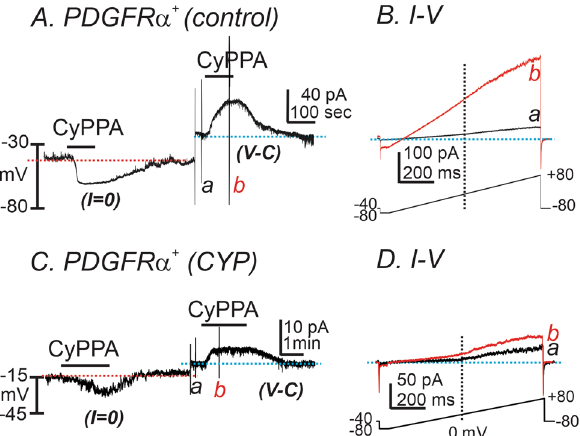
Figure 4. The effect of SK channel activator on membrane currents and potential in PDGFRα + cells from control and CYP-treated mice. ( A ) In detrusor PDGFRα + cells from control bladders, CyPPA (10 μM) induced membrane hyperpolarization under current clamp ( I = 0, red dot line). In the same cell, CyPPA activated outward current (current above blue dotted line) at a holding potential of − 40 mV under voltage-clamp mode (V-C). ( B ) Current responses to ramp-depolarizations from ( A ) before (a) and during (b) CyPPA. Inset denotes voltage-protocol. ( C ) In detrusor PDGFRα + cells from CYP-treated bladders, CyPPA (10 μM) induced membrane hyperpolarization under current clamp ( I = 0, red dot line). In the same cell, CyPPA activated outward current (current above blue dotted line) at a holding potential of − 40 mV under voltage-clamp mode (V-C). ( D ) Current responses to ramp-depolarizations from ( C ) before (a) and during (b) CyPPA. Inset denotes